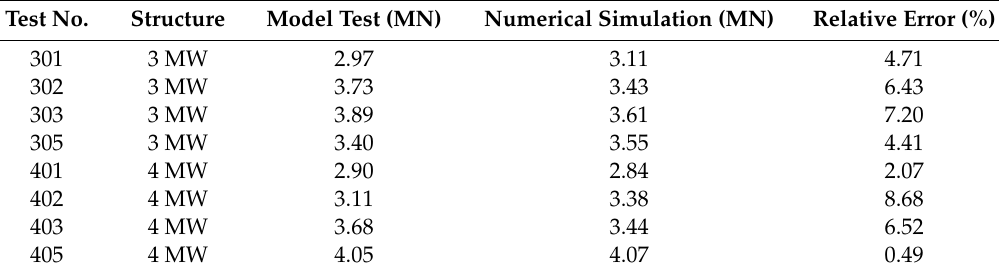
Table 7. Comparison of maximum ice load from the model test and simulation.